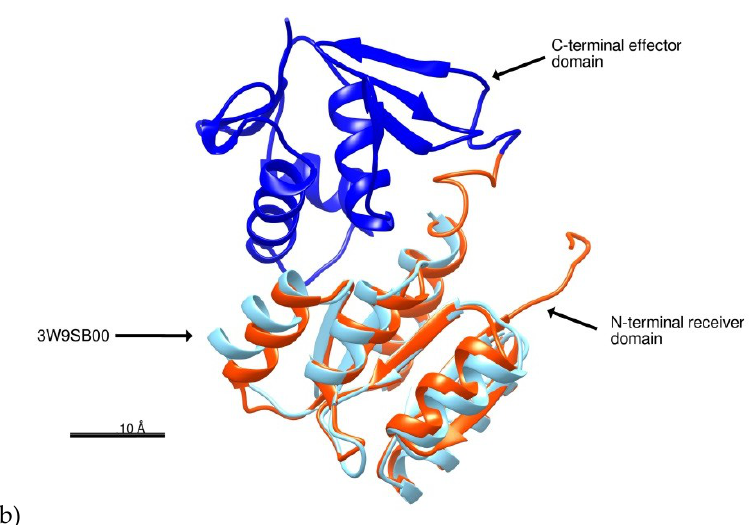
Figure 2. Structural prediction of BvrR. ( a ) C -terminal effector domain of BvrR (blue) compared with the domain 4MLOA02 of the transcriptional activator protein ToxT (pink). ( b ) N -terminal receiver domain of BvrR (red) compared with the domain 3W9SB00 of the N -terminal receiver domain of Response Regulator PmrA (light blue). The proteins were represented schematically with Chimera software developed by The National Institutes of Health (NIH) [31].